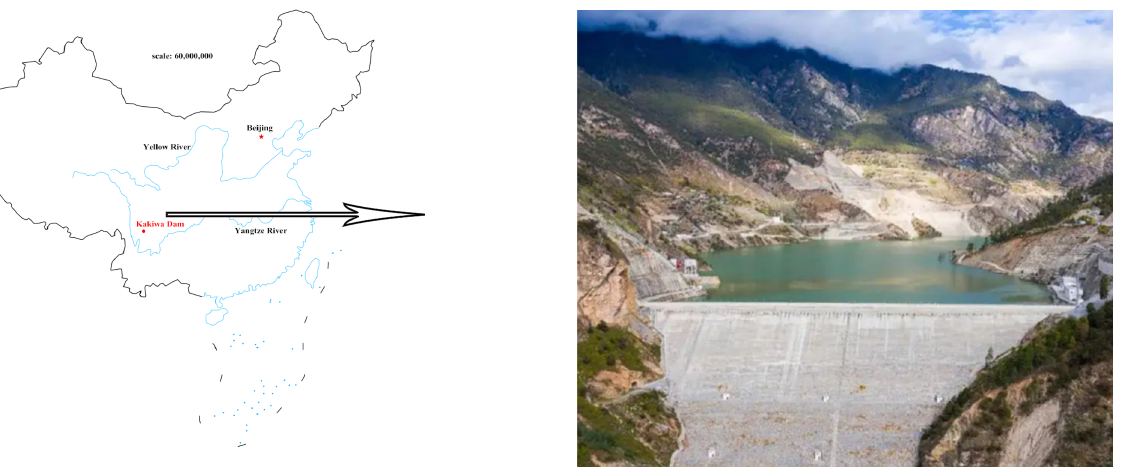
Figure 4. The location of the Kakiwa Dam.